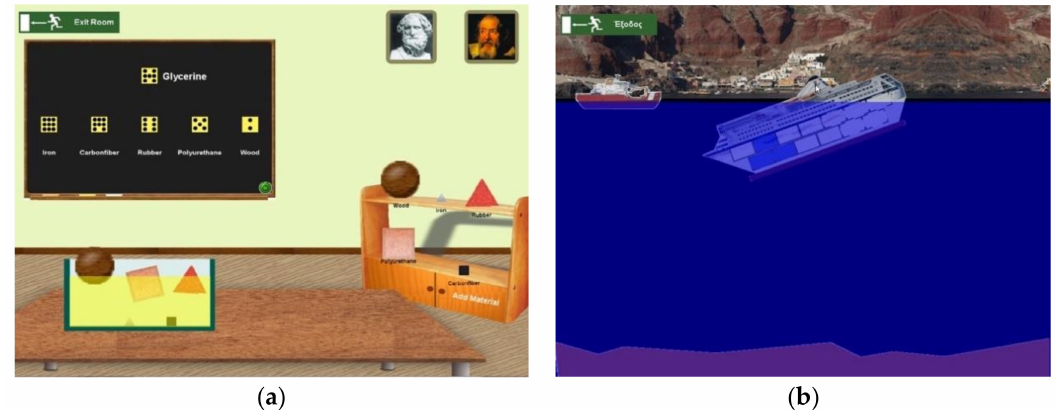
Figure 4. ( a ) A simulated experiment using glycerin instead of water, reprinted by permission from Springer Nature Customer Service Centre GmbH: Springer, Iterative design of Teaching-Learning Sequences, by D. Psillos and P. Kariotoglou, 2016; ( b ) simulated environment to investigate FS of the Sea Diamond